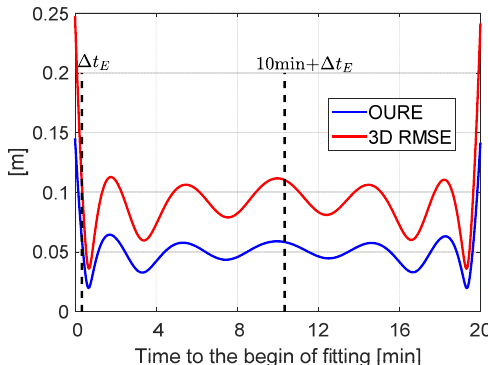
Figure 11. The OURE and the 3D RMSE of the ephemeris fitting errors within a 20-min fitting interval using 20 ephemeris parameters. The dashed lines mark the time interval in which the ephemeris is used by the users.